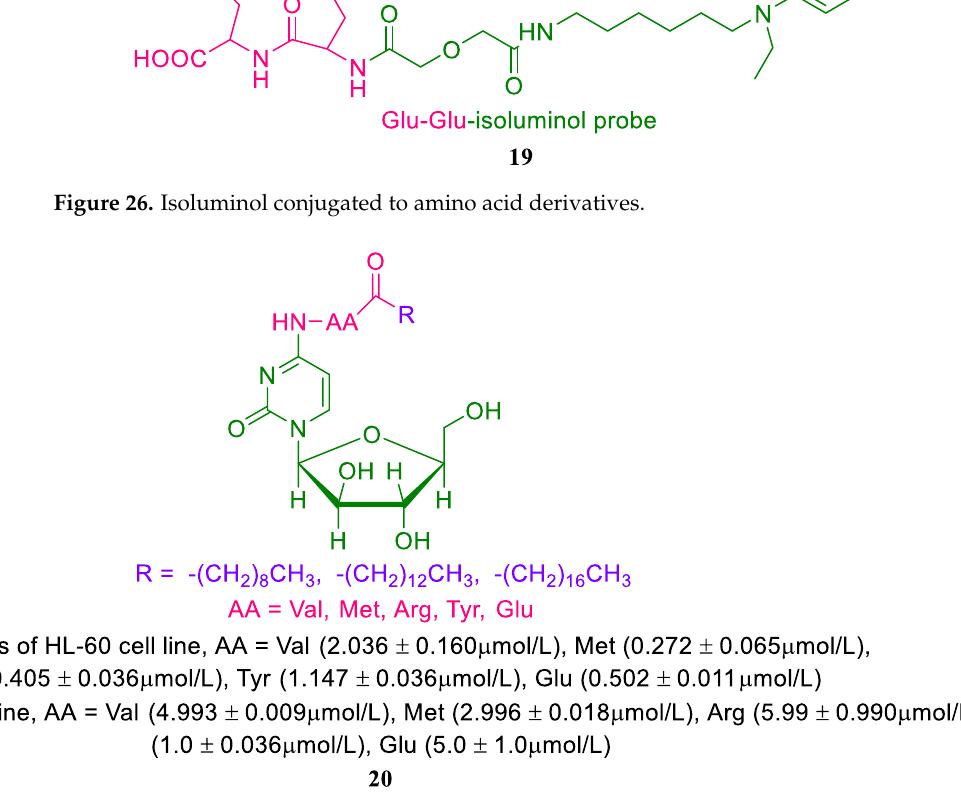
Figure 27. Amino acid conjugated to Ara-C (cytarabine)